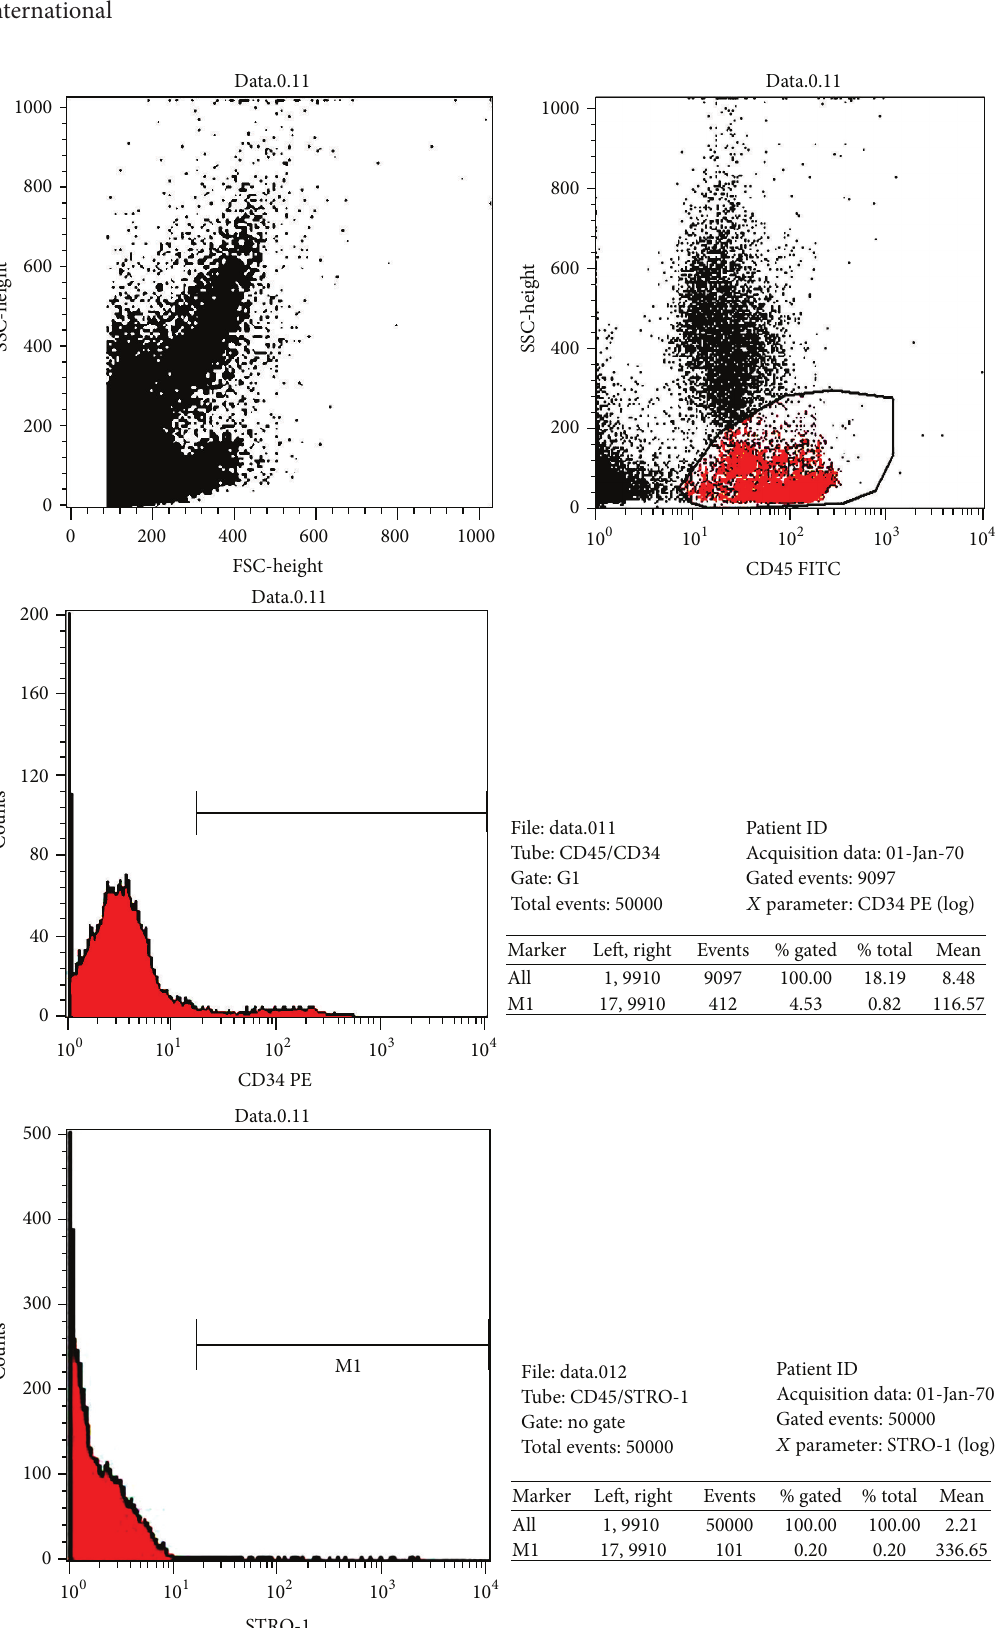
Figure 1: Representative picture of flow cytometric analysis. Mononuclear CD45 − /CD34 − /CD271+/STRO-1+ cells defined as bone marrow mesenchymal stem cell and their enumerated percentage and absolute count. Bone marrow hematopoietic stem cells determined in CD45+/CD34+ mononuclear cell population and their enumerated percentage and absolute